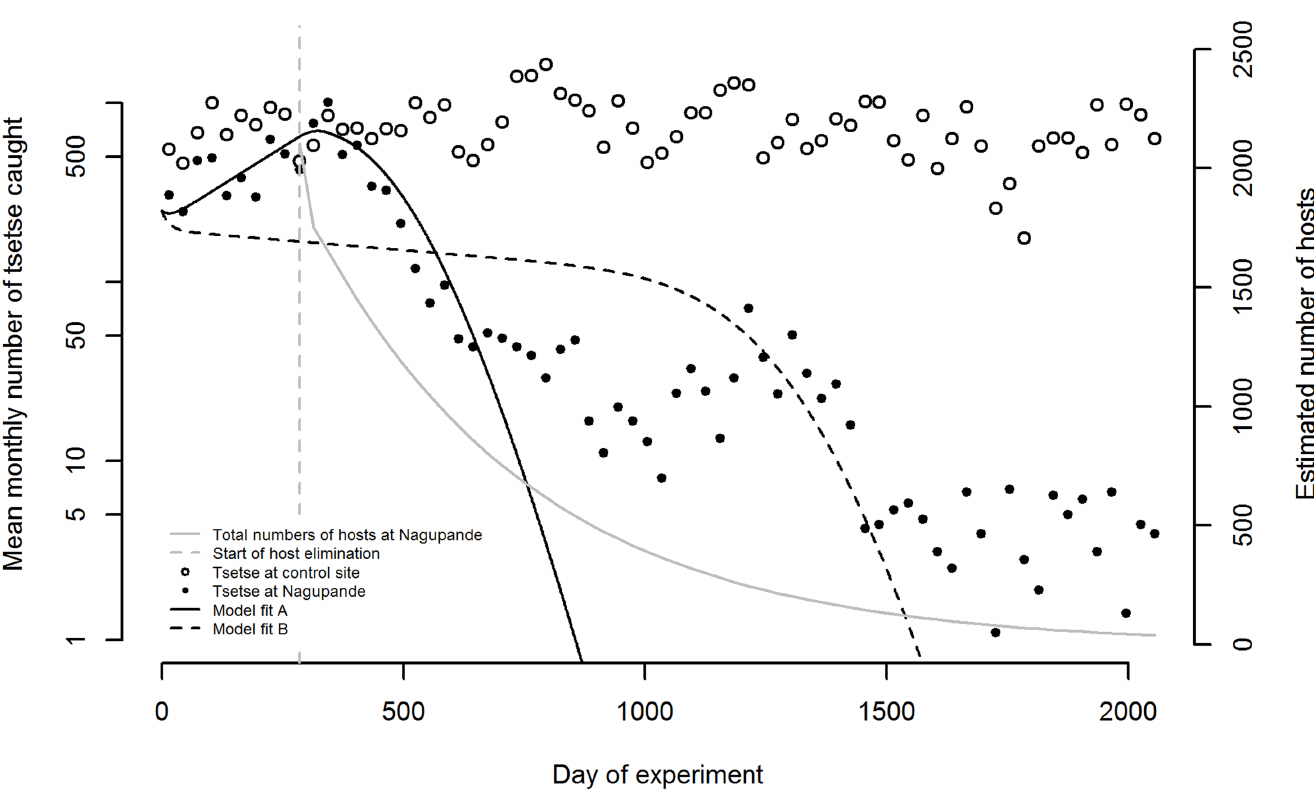
Fig 3. Ordinary differential equation (ODE) model fits to the mean monthly number of tsetse caught during ox-baited fly-round, and estimated number of hosts during the Nagupande experiment. Host numbers assumed constant prior to the start of hunting. Mean monthly catches of G . m . morsitans in the Nagupande area (closedcircles) and at the control site in Lusulu (open circles) are plotted on a logarithmic scale. Model fit A: fitting both σ (daily probabilityof finding and feedingon a host, given one host present within a squareof side 1 km area aroundthe fly), and μ b (adult background mortality rate). σ = 0.124 (0.123–0.125); μ b = 0.0180 (0.0176–0.0183)days -1 ; log likelihood 2216. Model fit B: assumingno mortality due to starvation ( σ = 1) and fitting only background mortality μ b , 0.03697(0.03696–0.03699) days -1 ; log likelihood4694. Fits use the values for input parameters given in Table 1. Note that we here assume no movement of flies into and out of the experimental plot.